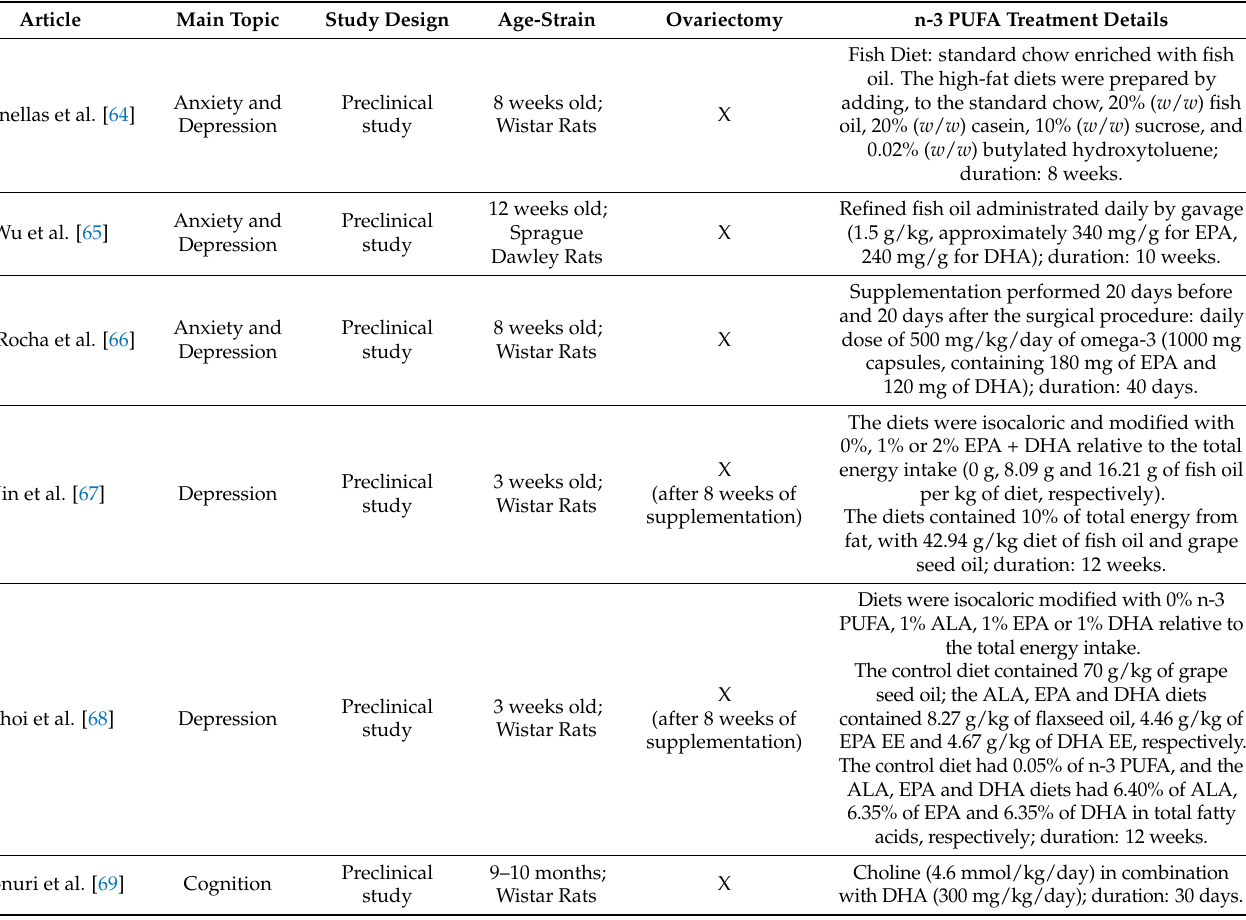
Table 1. Data extracted from rodent studies: topic, study design, age, sample and